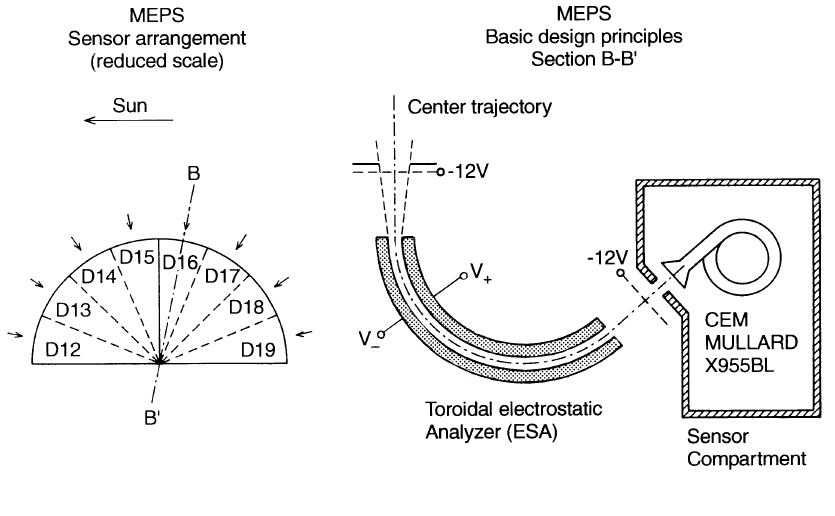
Fig. 2. Basic design principles of MEPS